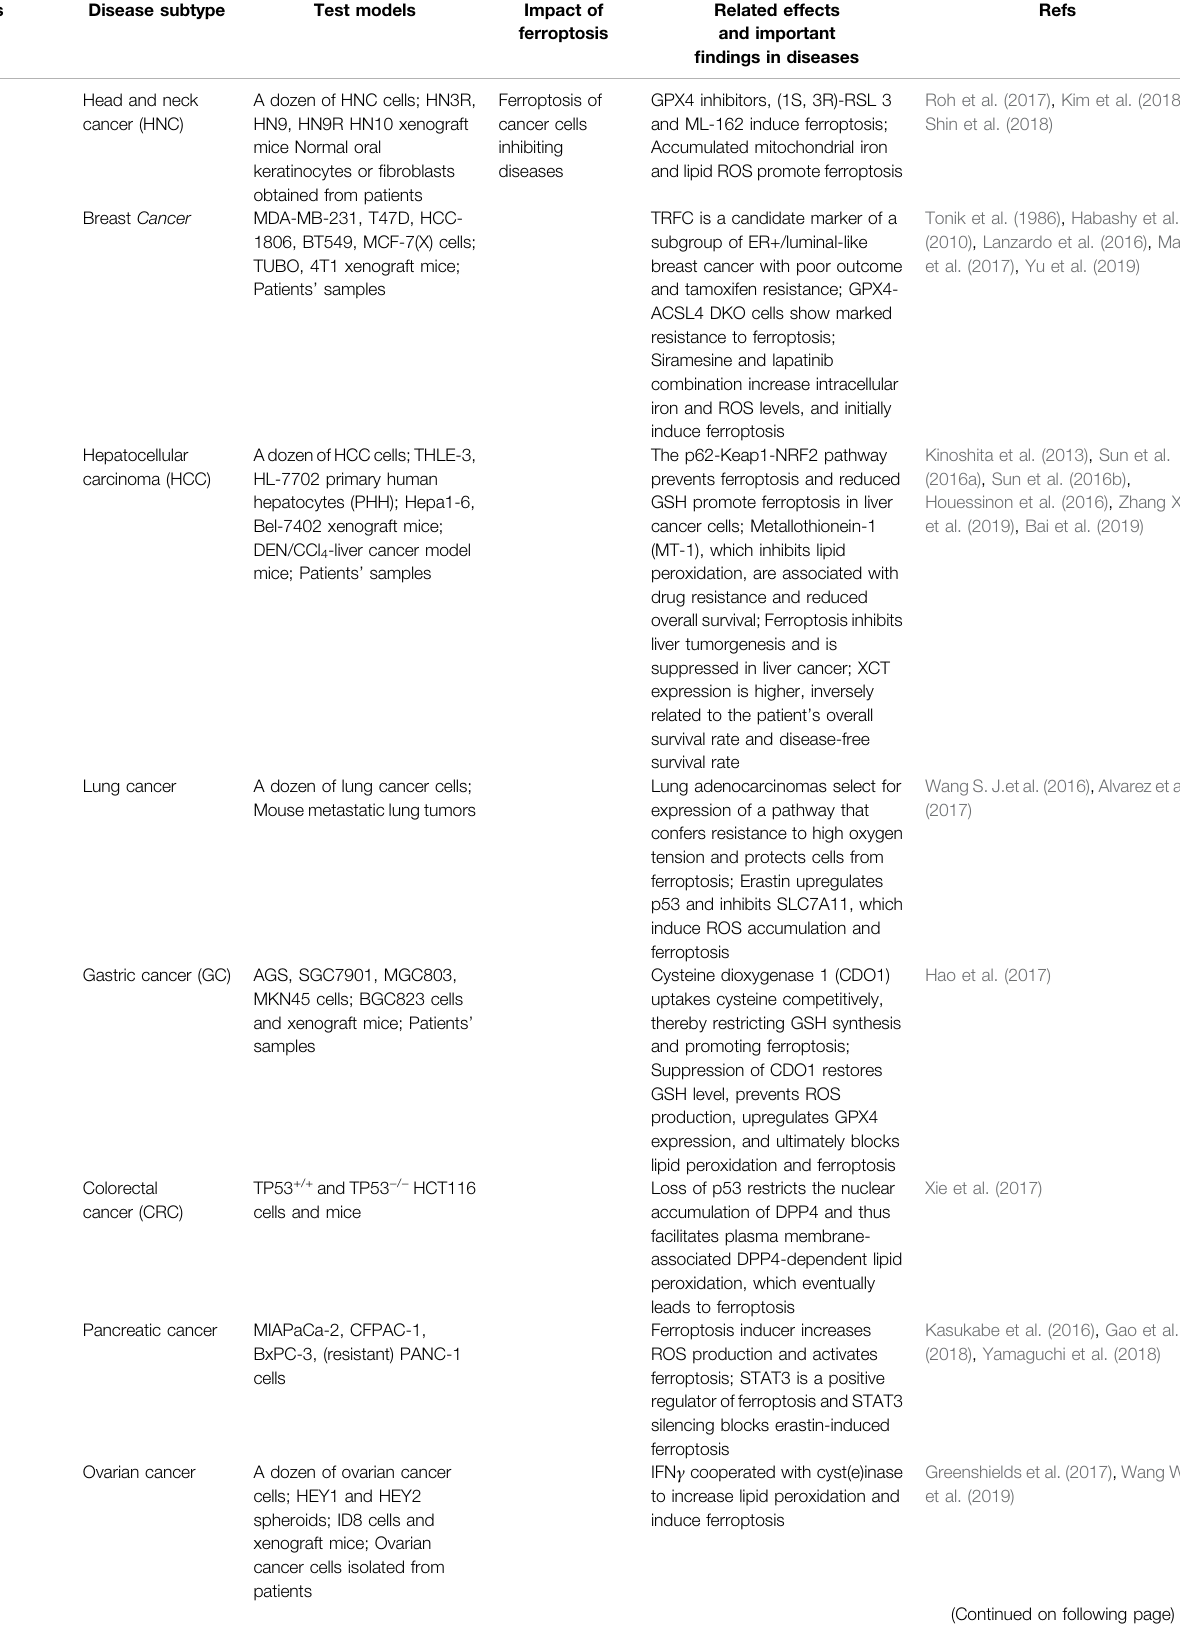
TABLE 1 | The relevance of ferroptosis in diseases.